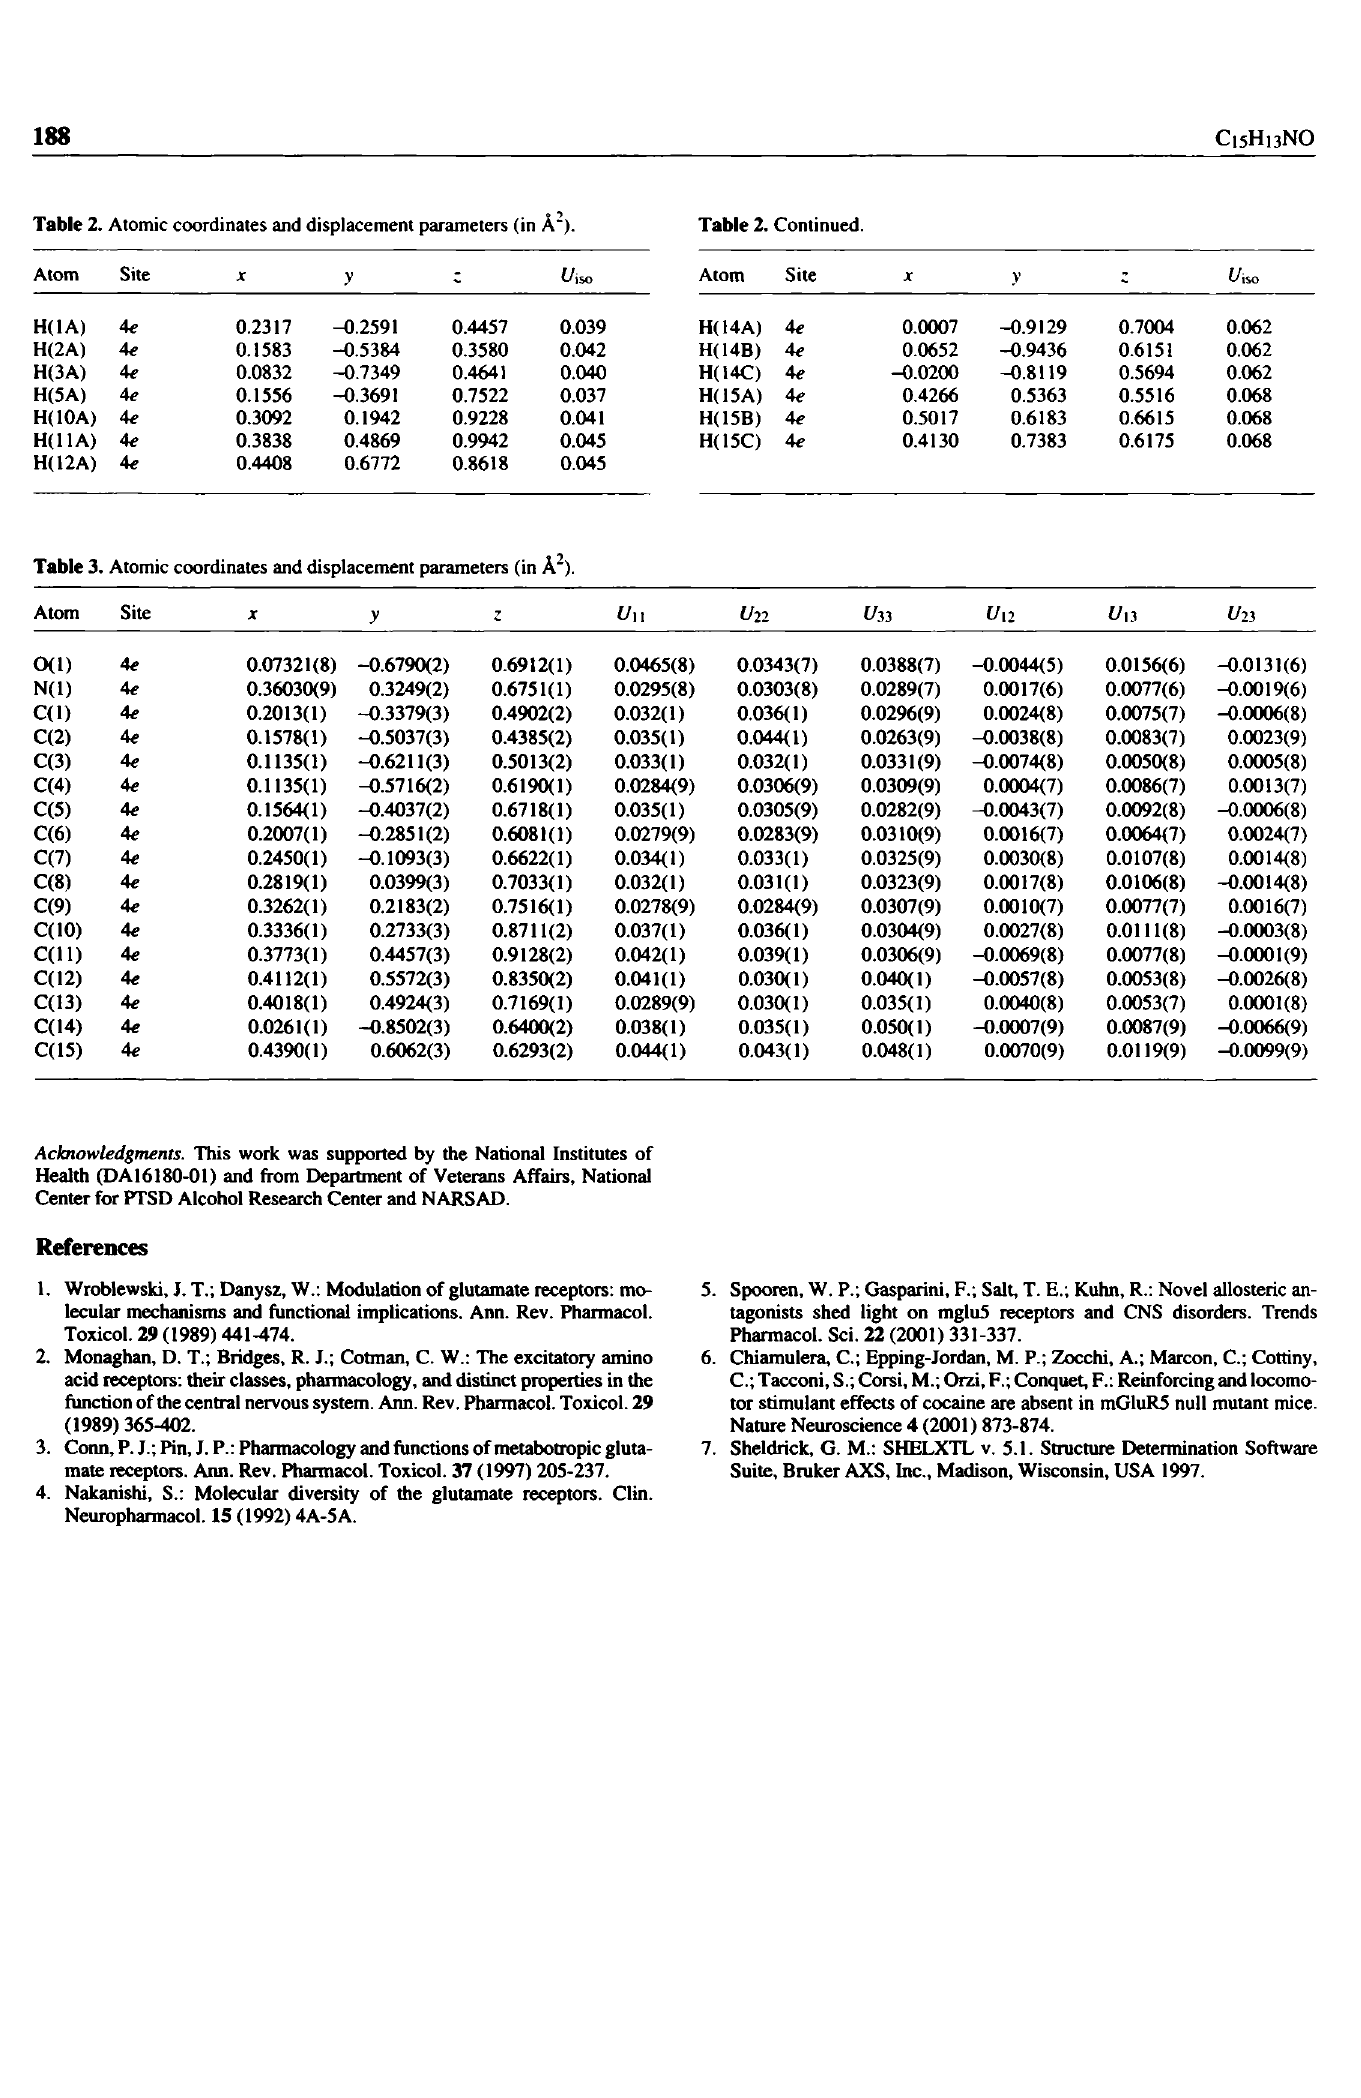
Table 3. Atomic coordinates and displacement parameters (in